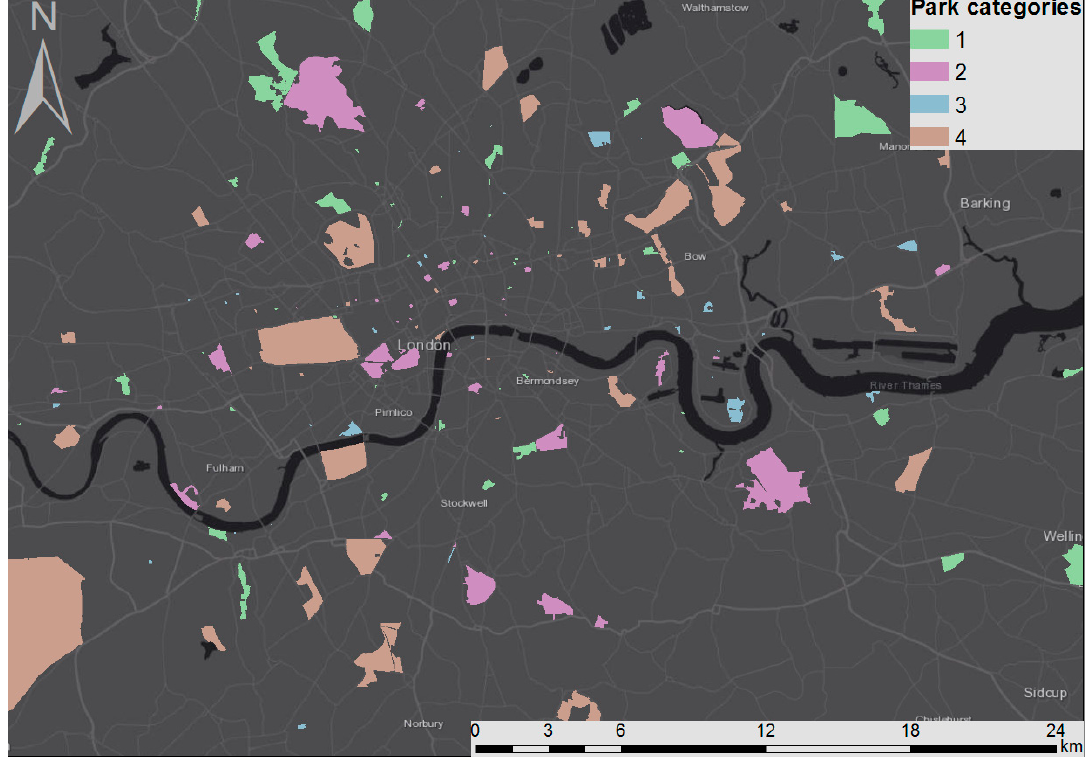
Figure 19. Final park categories.